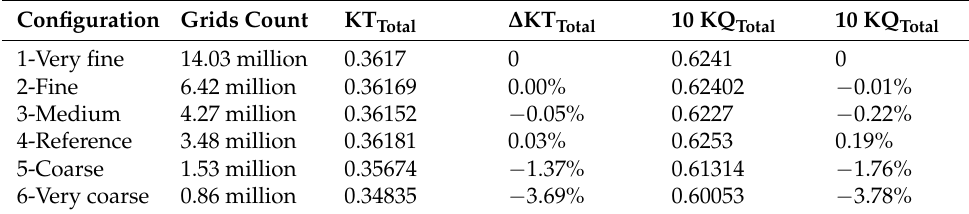
Table 3. Grid sensitivity analysis.